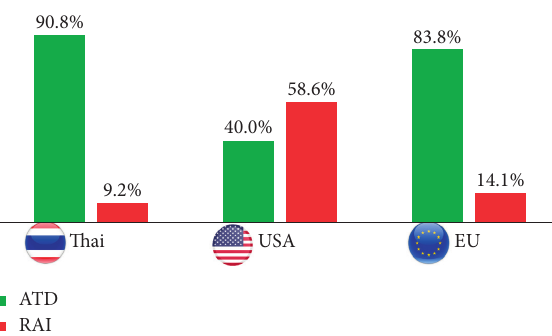
Figure 2: International differences in the selection of primary treatment modalities for the index case of uncomplicated Graves’ disease. USA and EU data are from references [5] and [6], respectively. ATD, antithyroid drug; EU, Europe; RAI, radioactive iodine; USA, United States of selected by 80.8% of the respondents, whereas the block- propylthiouracil (PTU) were 50 mg three times daily by 30% and-replace regimen was always used by 0.8% of respon- of the respondents, 100 mg three times daily (27.5%), and dents and in selected cases by 18.3%. 150 mg three times daily (19.2%). The titration regimen was